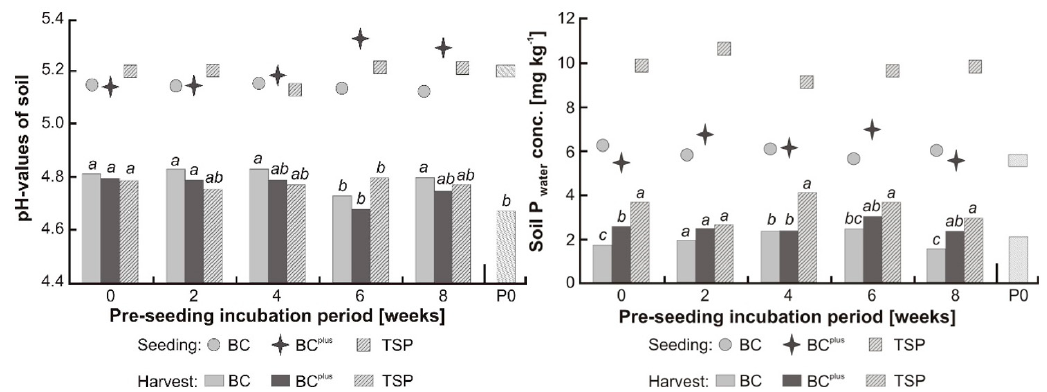
Figure 2. Mean pH-values ( left ) and water soluble P ( right , P water ) in soil at seeding and harvest at different pre-seeding incubation periods of fertilizers BC, BC plus and TSP in comparison to P0. Differences between fertilizers at harvest, for each pre-seeding incubation period, are indicated by letters and are significant ( p ≤ 0.05) when fertilizers are not connected by the same